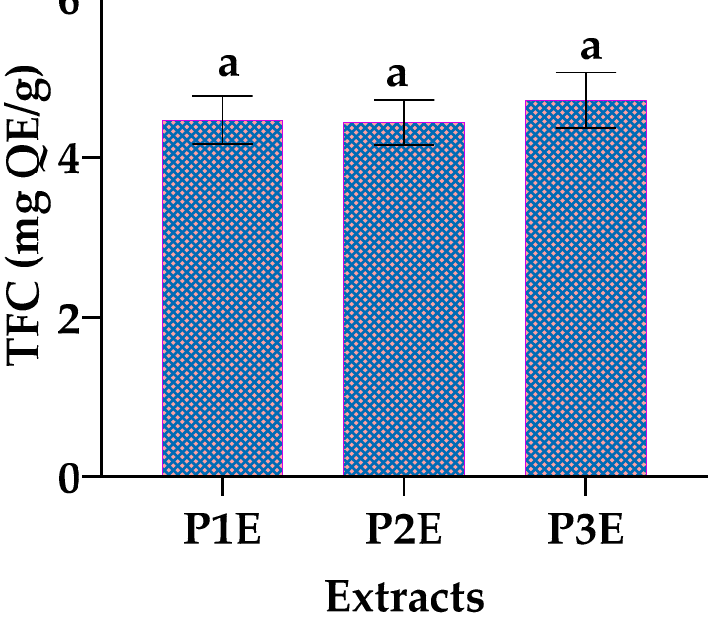
Figure 2. Flavonoid content in PE1, PE2, and PE3; QE: quercetin equivalents; a: the difference between the three samples was not significant ( p > 0.05).